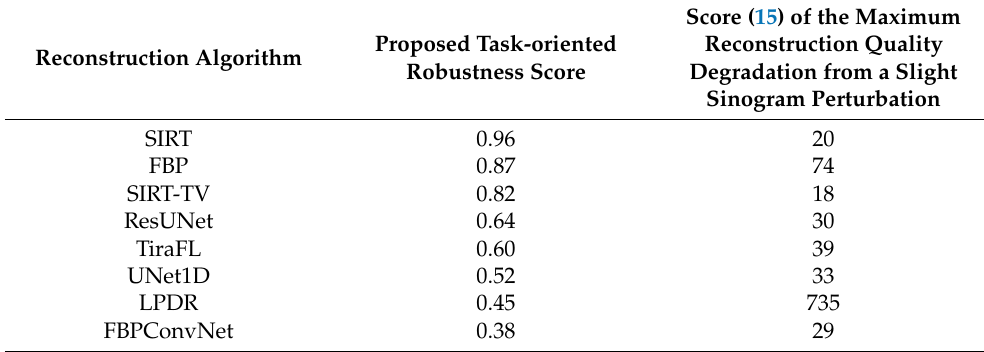
Table 1. Robustness scores calculated for “perturbation A” shown in Figure 5 over a single image (also shown in Figure